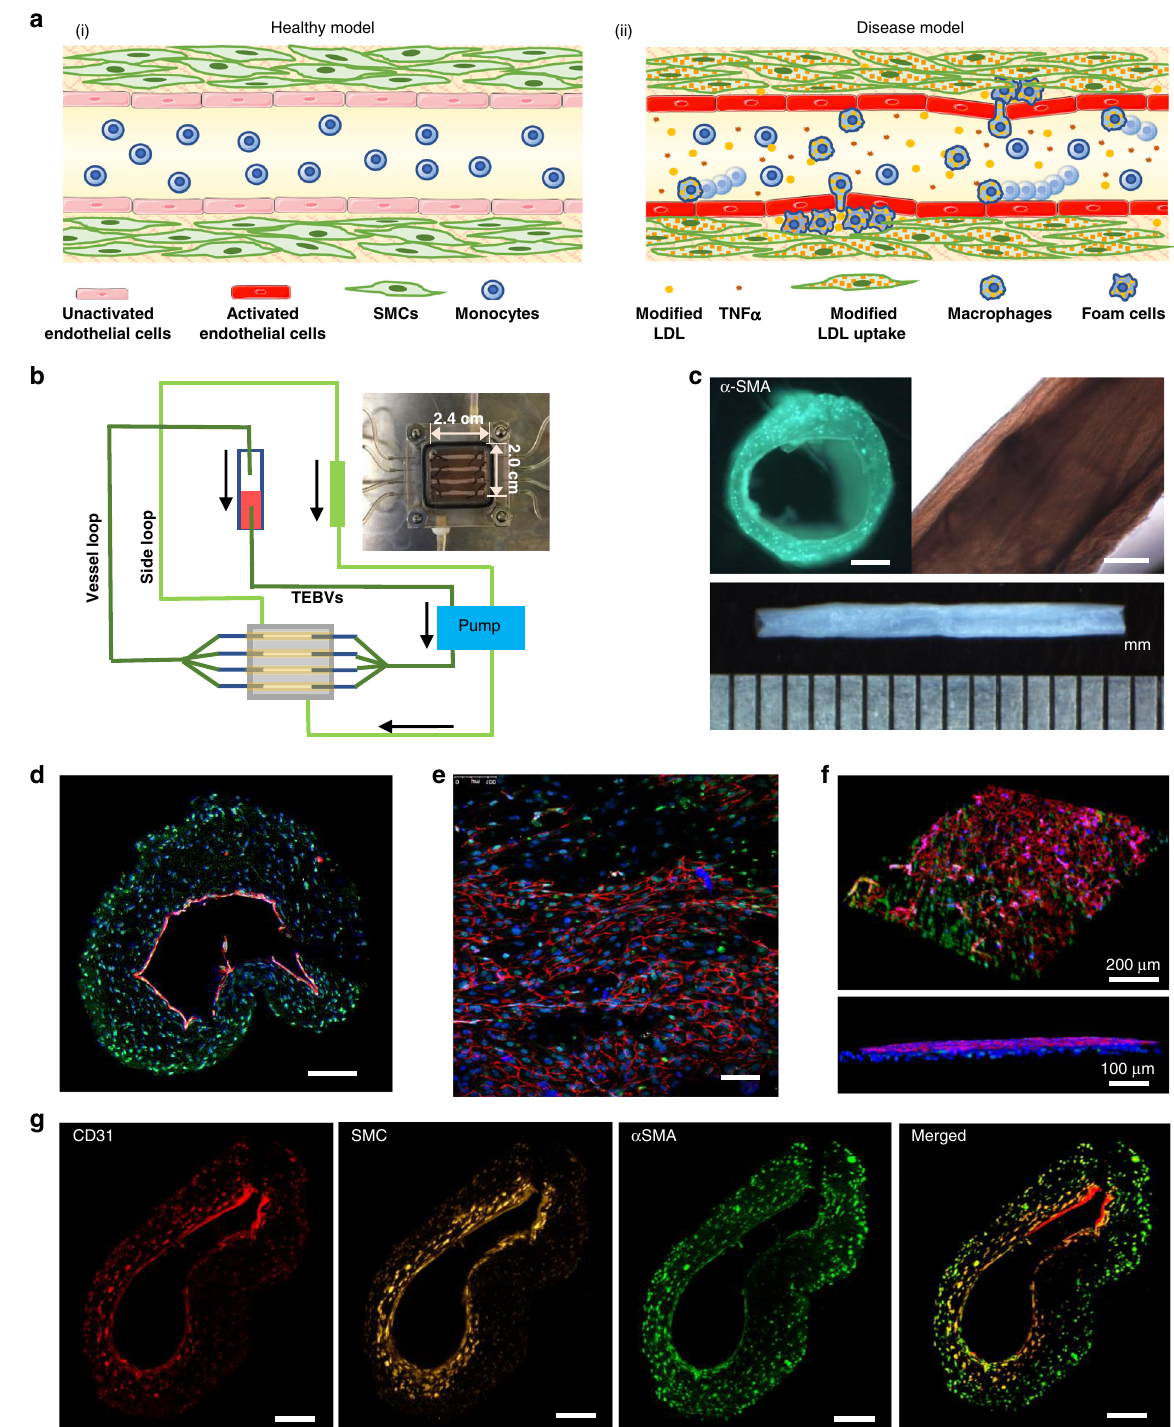
Fig. 1 Fabrication and characterization of tissue-engineered blood vessels (TEBVs.). a Under healthy conditions (i), monocytes do not adhere to the endothelium. Under disease conditions (ii), modi fi ed forms of LDL (low-density lipoprotein), or cytokines such as TNF α , activate the endothelium to increase expression of leukocyte adhesion molecules and release cytokines that enable monocytes to adhere to the endothelium and transmigrate into the media. Modi fi ed LDL in the media is taken up by monocytes/macrophages and hSMCs (human smooth muscle cells) becoming foam cells. b Schematic diagram of the perfusion system. c Bright- fi eld views of TEBV. Scale bar = 200 µ m. d Cross-sectional view of 2-layer TEBV showing an intact CD31 positive endothelium; Scale bar = 200 µ m. e En face view of lumen showing CD31 positive endothelium overlying α SMA positive hNDF; Scale bar = 100 µ m. f 3D view of opened TEBV ( d – f : CD31-red, α SMA-green, DAPI-blue). g Cross-sectional view of 3-layer TEBV: endothelial layer (CD31-red), smooth muscle cell layer (cell tracker-yellow), fi broblast layer ( α SMA-green); Scale bar = 200 µ